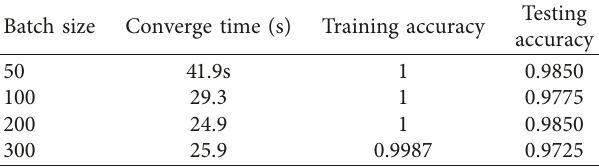
Table 3: Performance of model w.r.t different batch size.